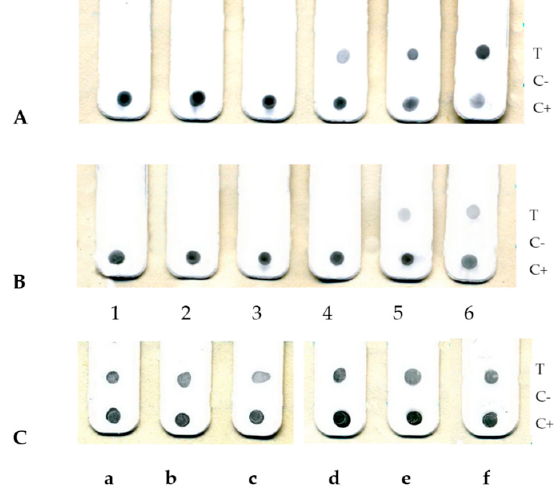
Figure 4. The results of dot-immunoassays of clinical samples from an infected rabbit. Type of protein arrays after the assays: ( A )-blood serum and ( B )-blood cells (the numbers under the arrays indicate the days from the moment of infection); ( C )-washes from the nasal mucosa ( a – c ) and homogenates of samples skin areas with papular rashes ( d – f ) every rabbit.